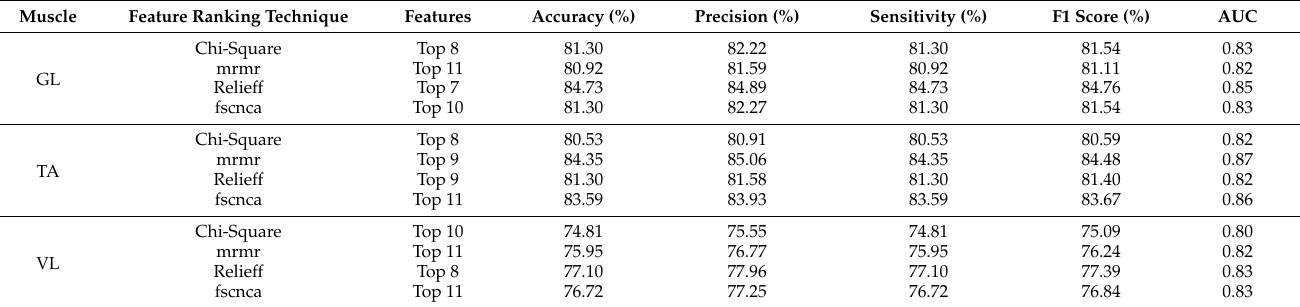
Table 3. Evaluation matrix for one-channel analysis for EMG data using different feature selection